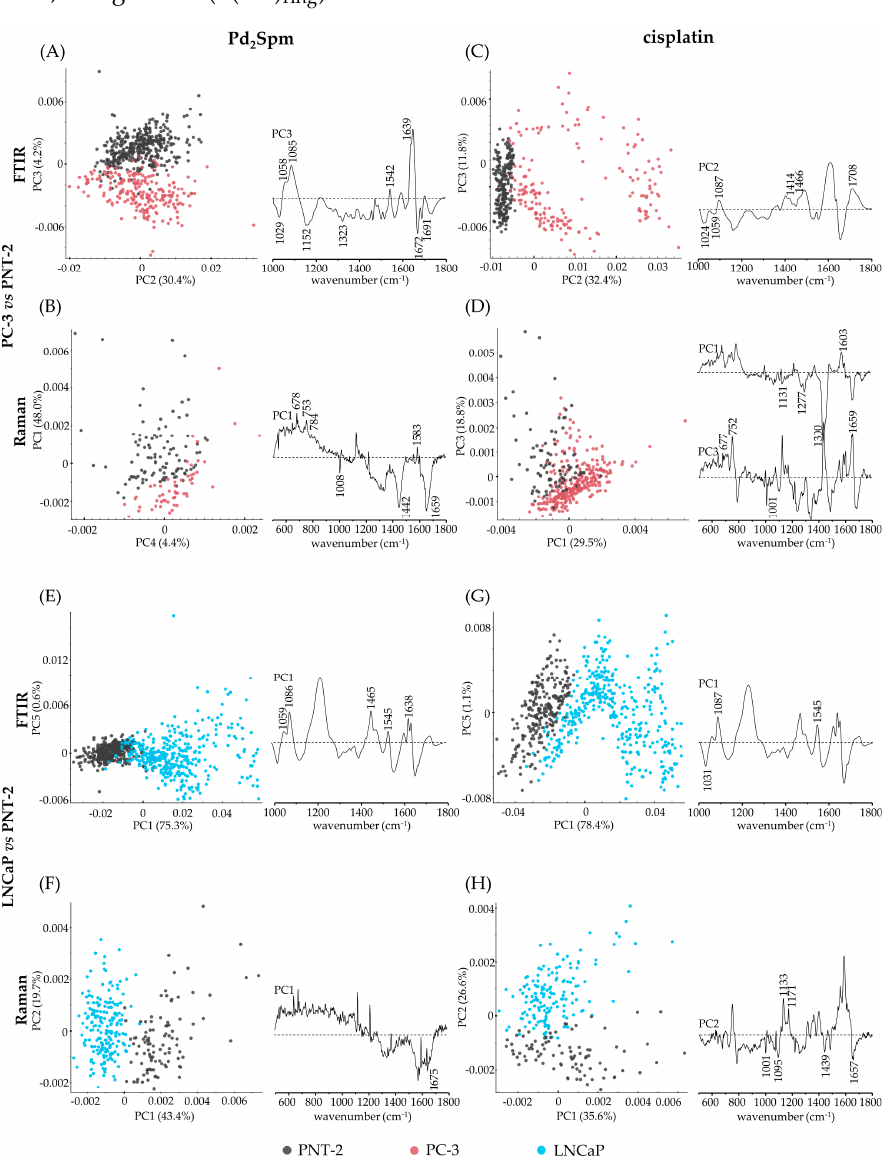
Figure 5. PCA scores and loading plots of FTIR (( A , C , E , G ); 1000–1800 cm − 1 ) and Raman (( B , D , F , H ); 500–1800 cm − 1 ) data for cisplatin- and Pd 2 Spm-treated prostate cancer cell lines PC-3 ( A – D ) and LNCaP ( E,F,G,H ) vs. the non-cancer cell line PNT-2. (For clarity, the loadings are offset, the dashed horizontal lines indicating zero loading).